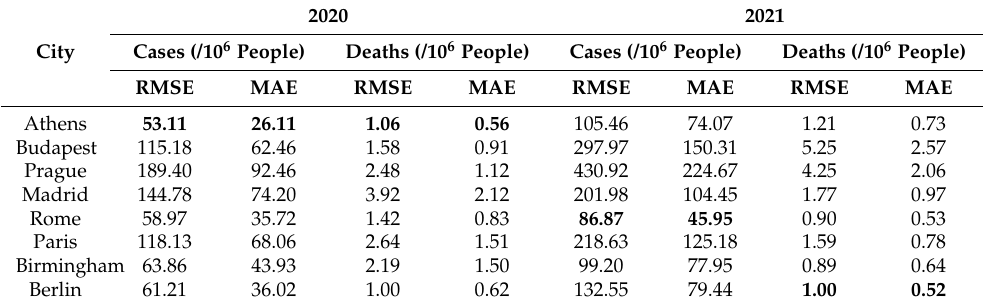
Table 5. The spatial and temporal variability of the performance errors in the proposed RF